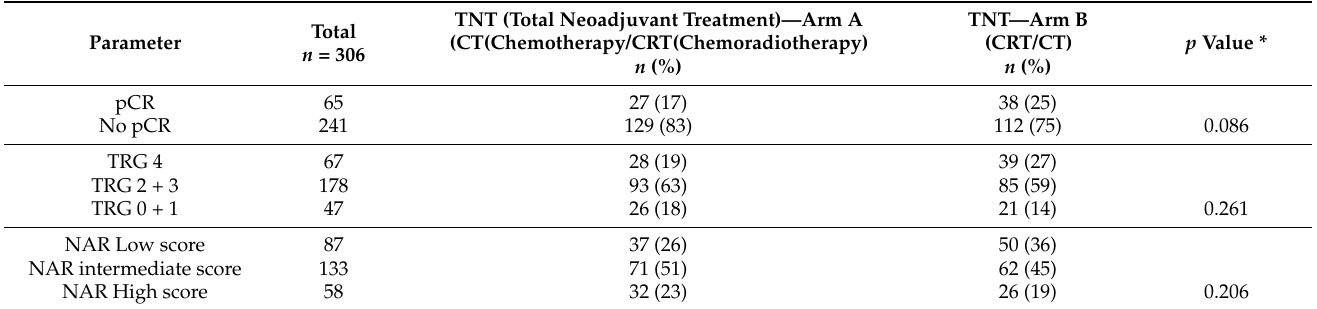
Table 1. Distribution of pCR, TRG and NAR score in the two treatment arms of the CAO/ARO/AIO- 12